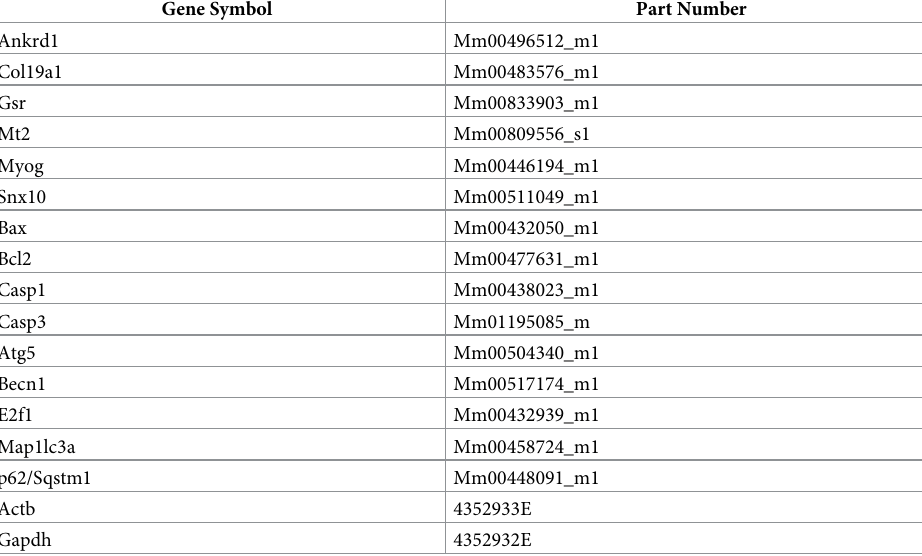
Table 1. Taqman gene expression assays used in the study. Gene Symbol Part